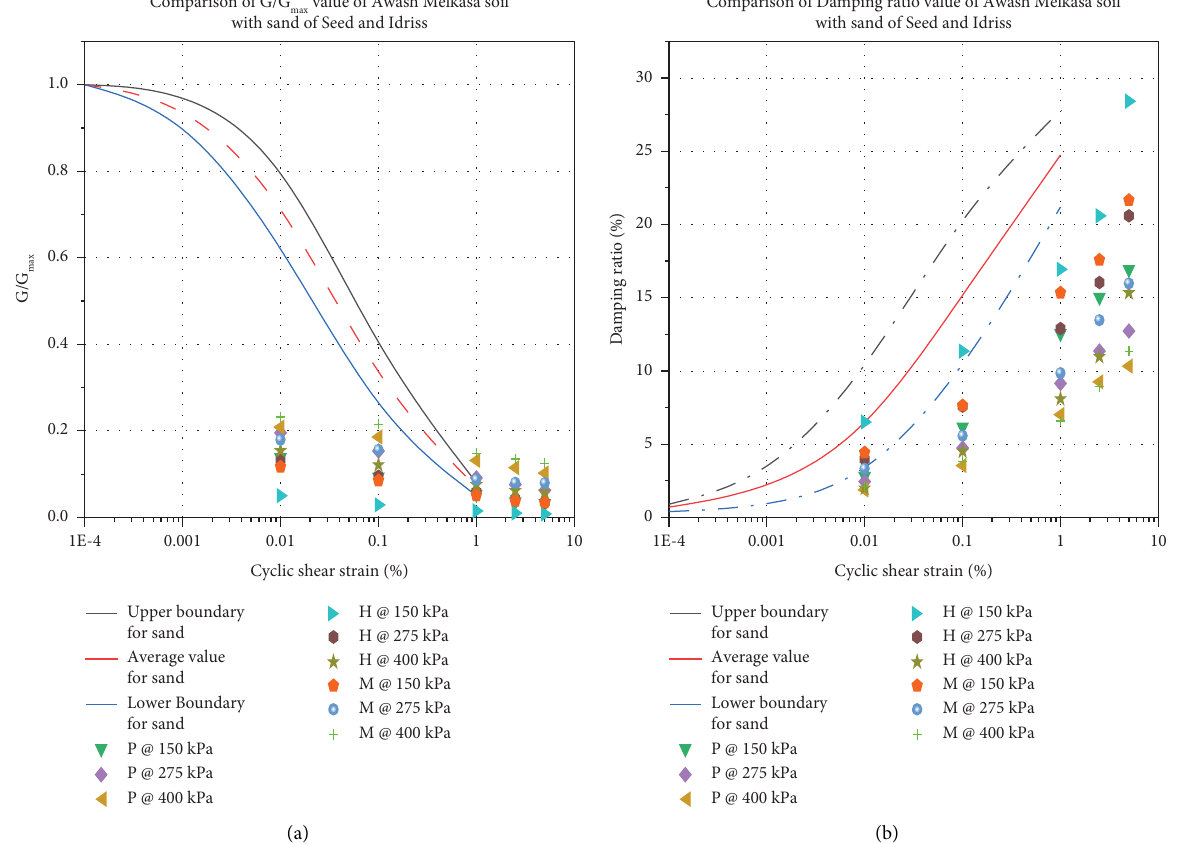
Figure 13: Comparison of Awash Melkasa soil with the sand soil of Seed and Idriss: (a) G / G